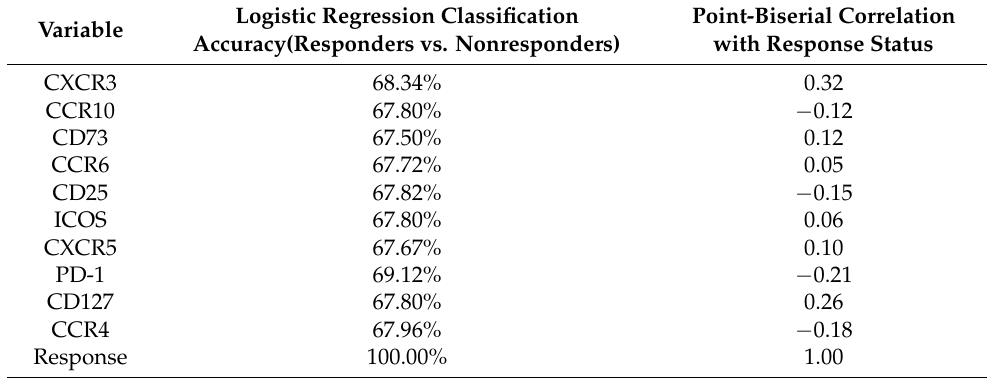
Table 4. Univariate logistic regression and point-biserial correlation results. (Adaptive panel, Naïve CD4+ T cells, responders vs. nonresponders at day 1). Classification accuracy was assessed using 10-fold cross-validation.